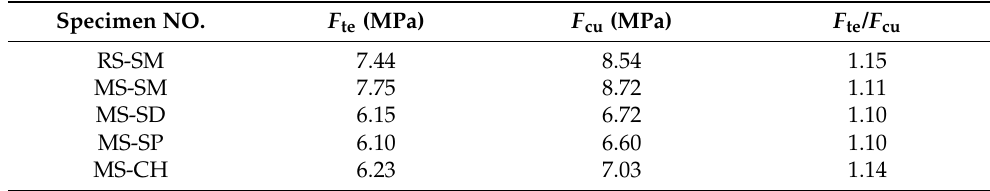
( a ) ( b ) Figure 9. Bonding properties of manufactured sand UHPC at different ages under different curing methods. ( a ) Ultimate bond strength. ( b ) Pullout energy.